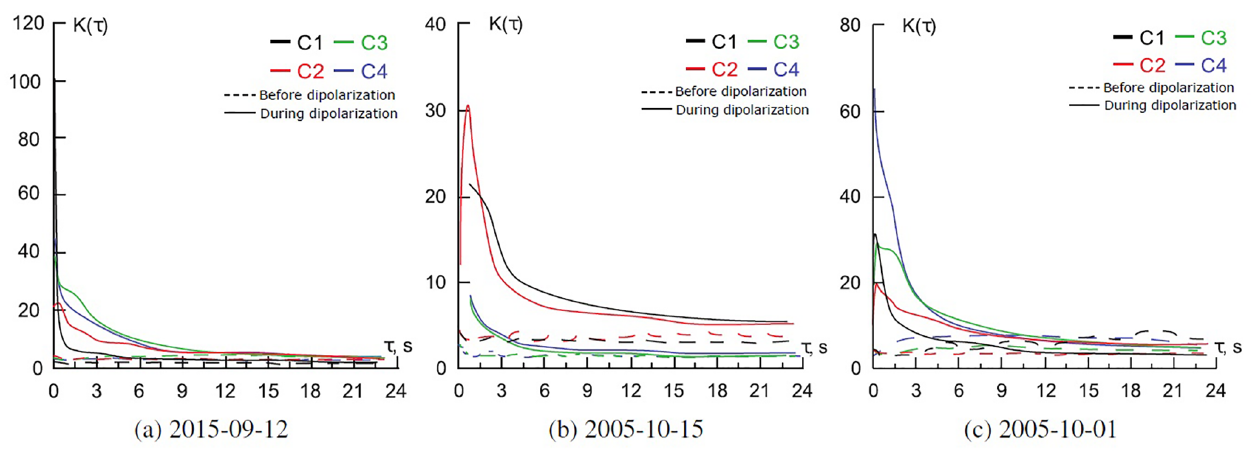
Figure 7. The results of